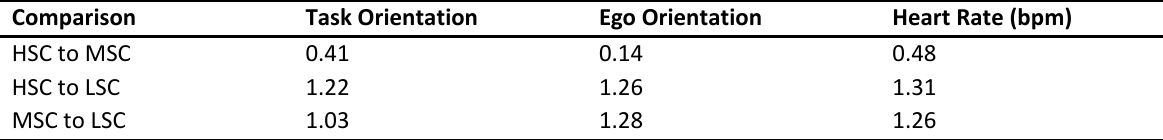
Table 2. Effect size value comparisons for the goal orientations and heart